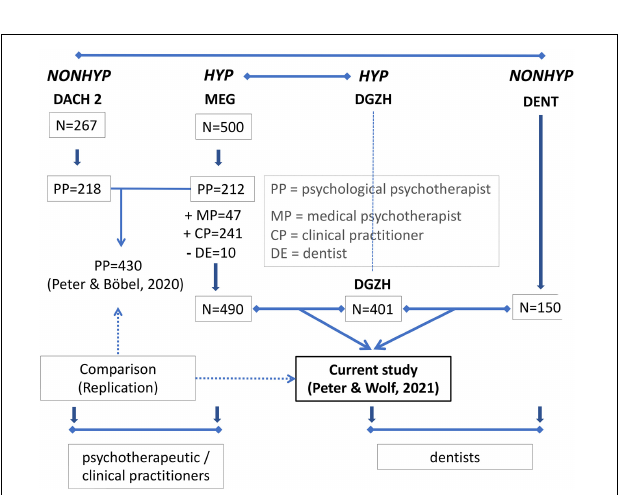
FIGURE 2 | Flowchart illustrating the samples used for the current